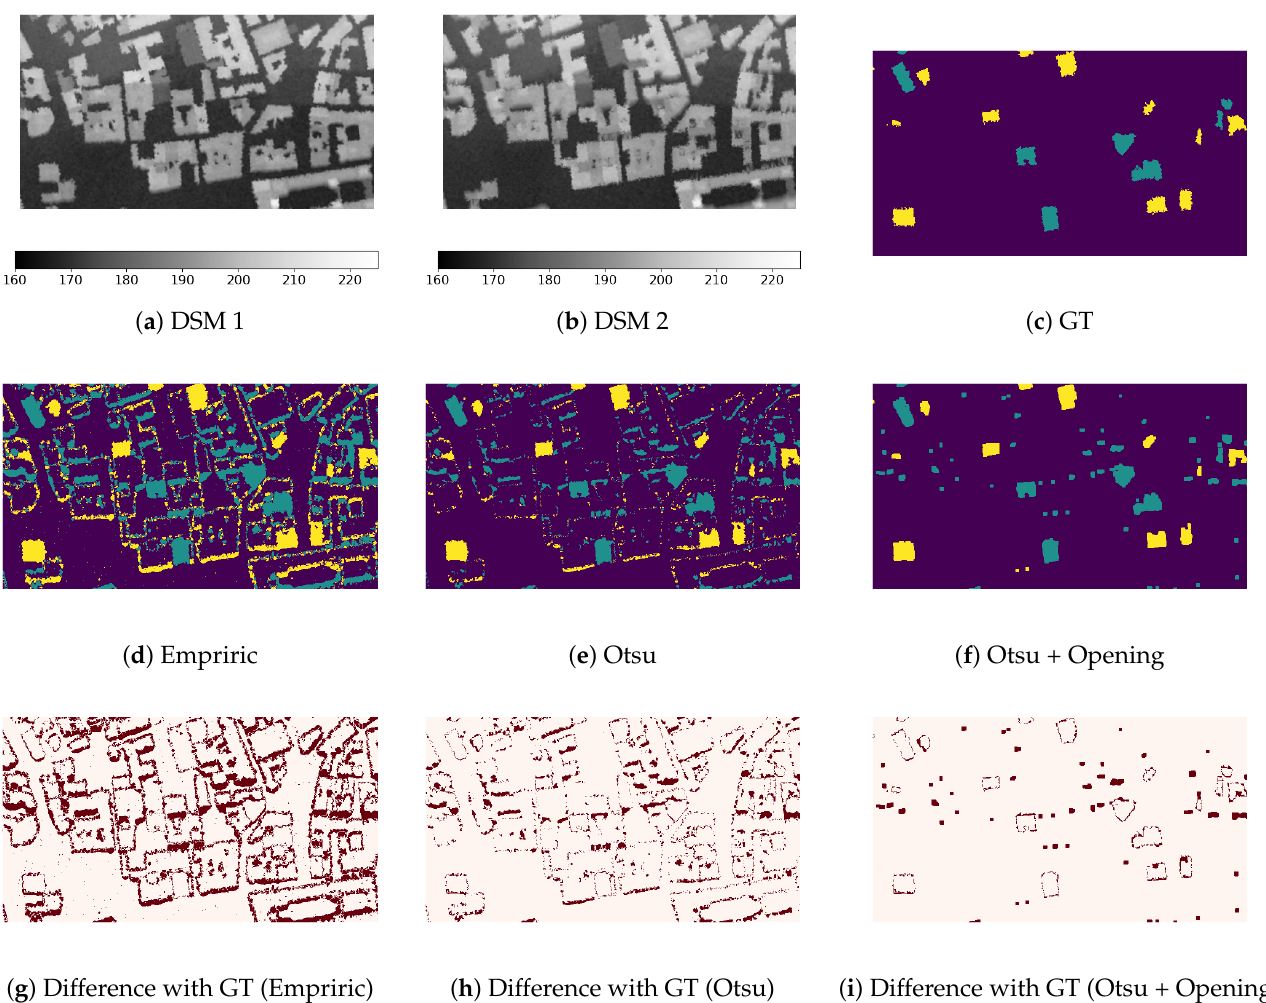
Figure 9. Results at the 2D pixel level for sub-dataset 3 (ALS, low resolution, high noise). ( a , b ) DSMs with their levels of elevation in meters and ( c ) ground truth (GT) with the following color code: purple for unchanged parts, blue for newly built parts and yellow for demolished parts. Results of DSMd with empirical thresholding ( d ), thresholds from the Otsu algorithm ( e ) and post-processing with an opening filter ( f ). Respective errors maps ( g – i ) highlight the differences (in red) from the ground